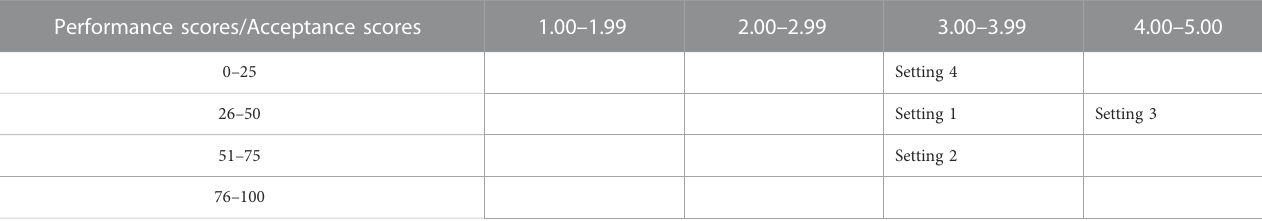
TABLE 12 Roboreadiness scores (white = acceptance, grey = no acceptance). Performance scores/Acceptance